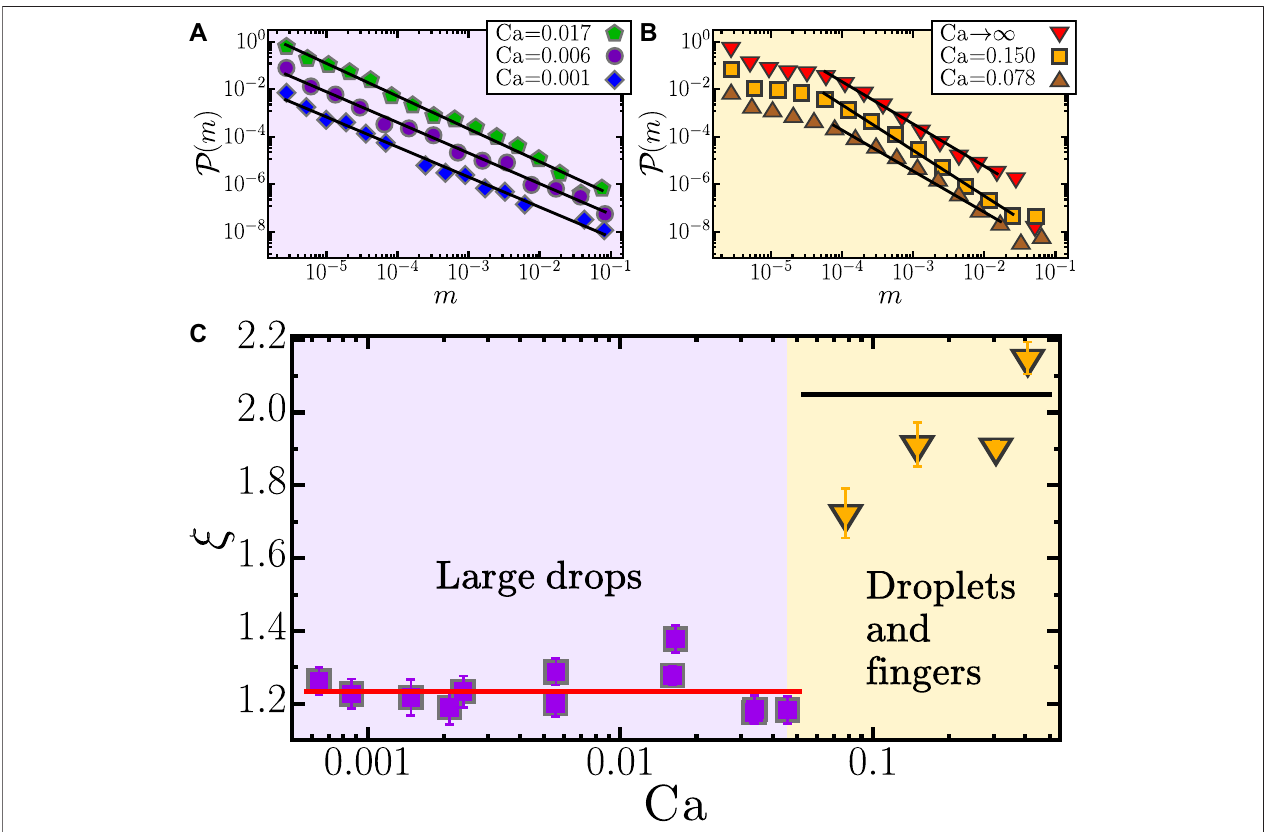
FIGURE 3 | (A,B) show the distributions of drop sizes, normalized by the amount of total fl uid, in the stationary regime for different values of Ca. The solid lines correspond to the best fi t of a power law to the data, P ( m ) ∝ m − ξ , whose exponent ξ depends on the capillary number. For better visibility, the different power laws are shifted by one order of magnitude with respect to each other, vertically. The (A) shows cases for small values of Ca, while (B) for high values of Ca. In (C) , ξ is plotted in terms of Ca. The exponent remains approximately constant for Ca ≲ 0.046, with average given by 1.23 ± 0.03, as indicated by the red line. Above this value, ξ increases quickly. In the limiting case of Ca → ∞ , the exponent is ≈ 2 . 05 ± 0 . 03, as indicated by the black